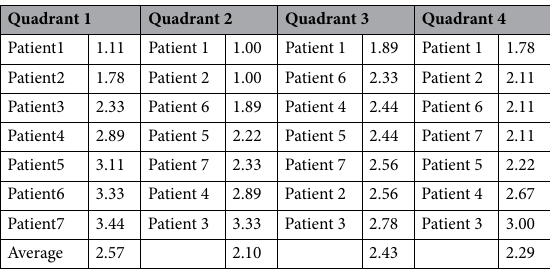
Table 2. Cartilage severity scoring according to outerbridge classification in the four anatomical regions defined; quadrant 1, quadrant 2, quadrant 3, quadrant